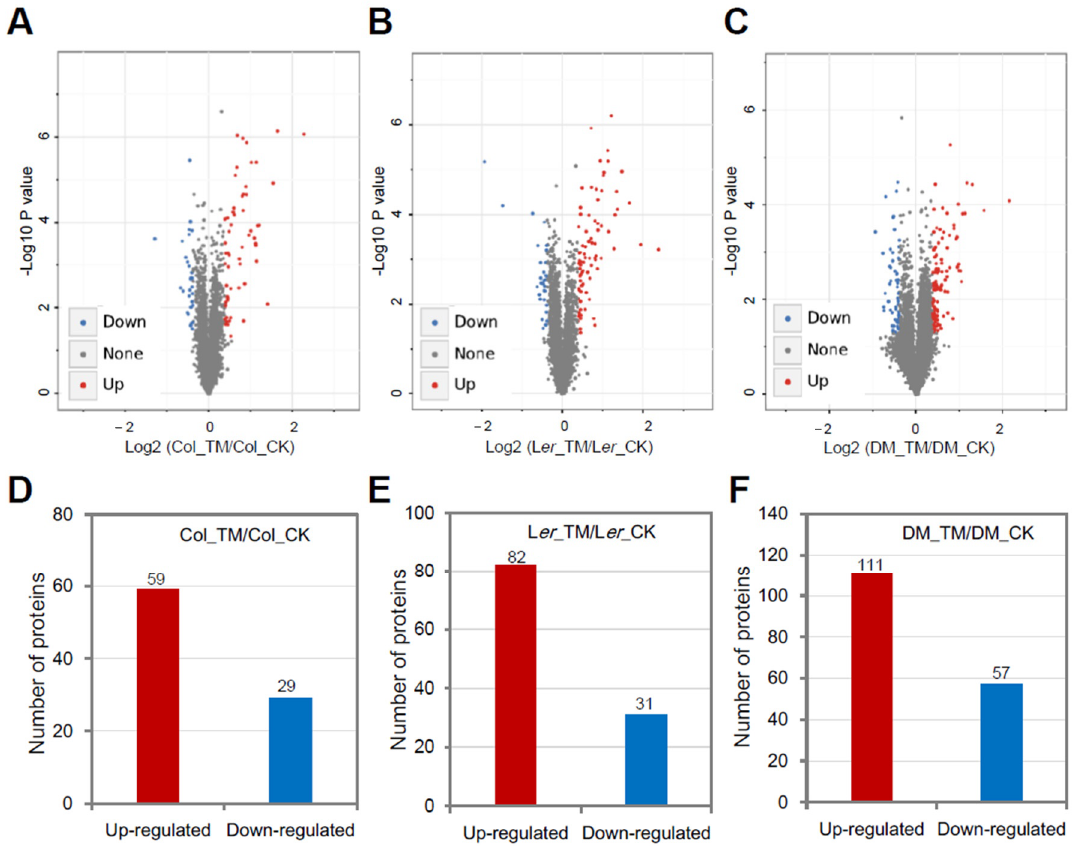
Figure 4. Di ff erentially regulated proteins by ER stress among Col, L er , and DM plants. ( A – C ) Volcano plots of di ff erential abundance of ER stress-regulated proteins among Col, L er , and DM plants. ( D – F ) Number of di ff erentially regulated proteins by ER stress in Col, L er , or DM plants. Parameters were set as fold change > 1.3 (upregulation) or < 0.7 (downregulation), p <